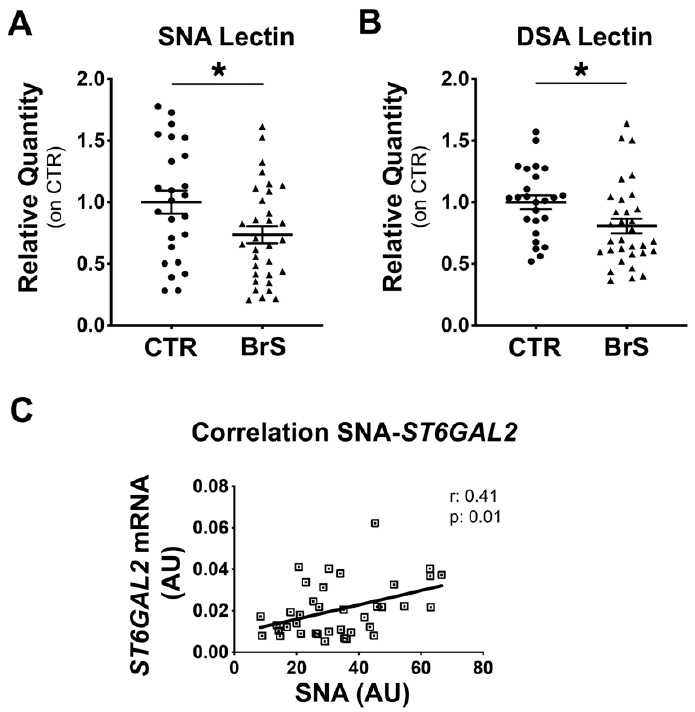
Figure 2. Sialylation analysis of membrane PBMCs proteins showed alterations in BrS patients. PBMCs isolated from healthy subjects (CTR) and BrS patients (BrS) were incubated with two specific lectins, SNA or DSA, to assess the sialylation or desialylation status of proteins, respectively and analyzed through flow cytometry. ( A ) Sialylated protein levels detected with the incubation with SNA lectin. ( B ) Desialylated protein levels detected with the incubation with DSA lectin. CTR: N = 25, BrS: N = 32. Data represent the mean ± SEM and are expressed as relative amounts compared with healthy controls. Statistical significance was determined by Student’s t -test. Each dot and triangles in the graphs represent a single healthy control and a single BrS patients, respectively. ( C ) The correlation between sialylation and ST6Gal2 was analyzed by comparing RNA expression levels of ST6Gal2 and the SNA levels in PBMCs. Each square in the graphs represents a single subject. N = 38. * p < 0.05.